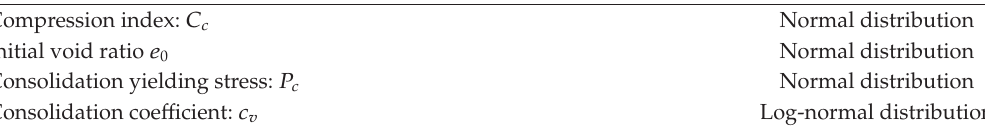
Table 1: Soil constants using first